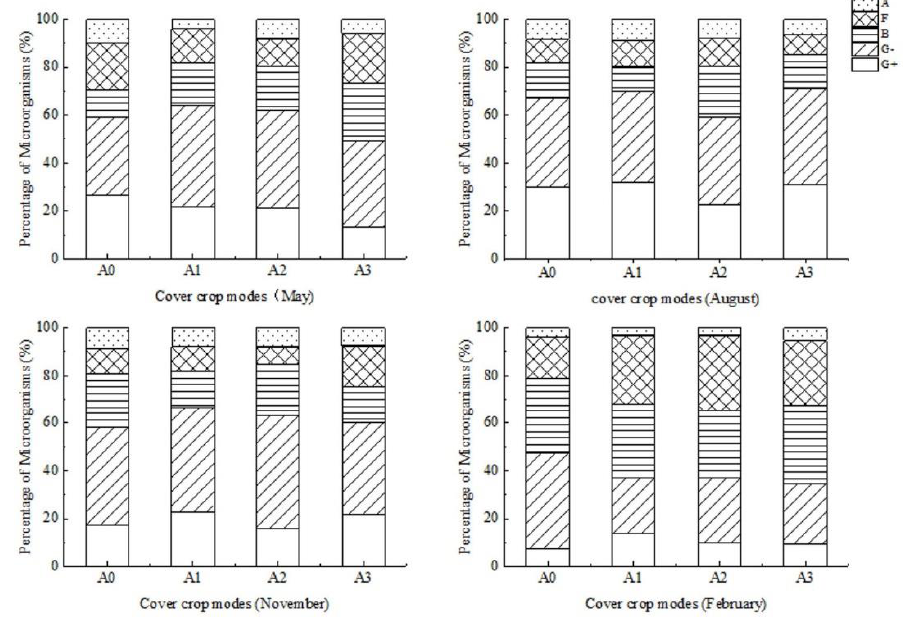
Figure 5. Changes of microbial communities under different cover crop patterns. G+, gram-positive bacteria; G–, gram-negative bacteria; A, actinomycetes; F, fungi; B, bacterial.